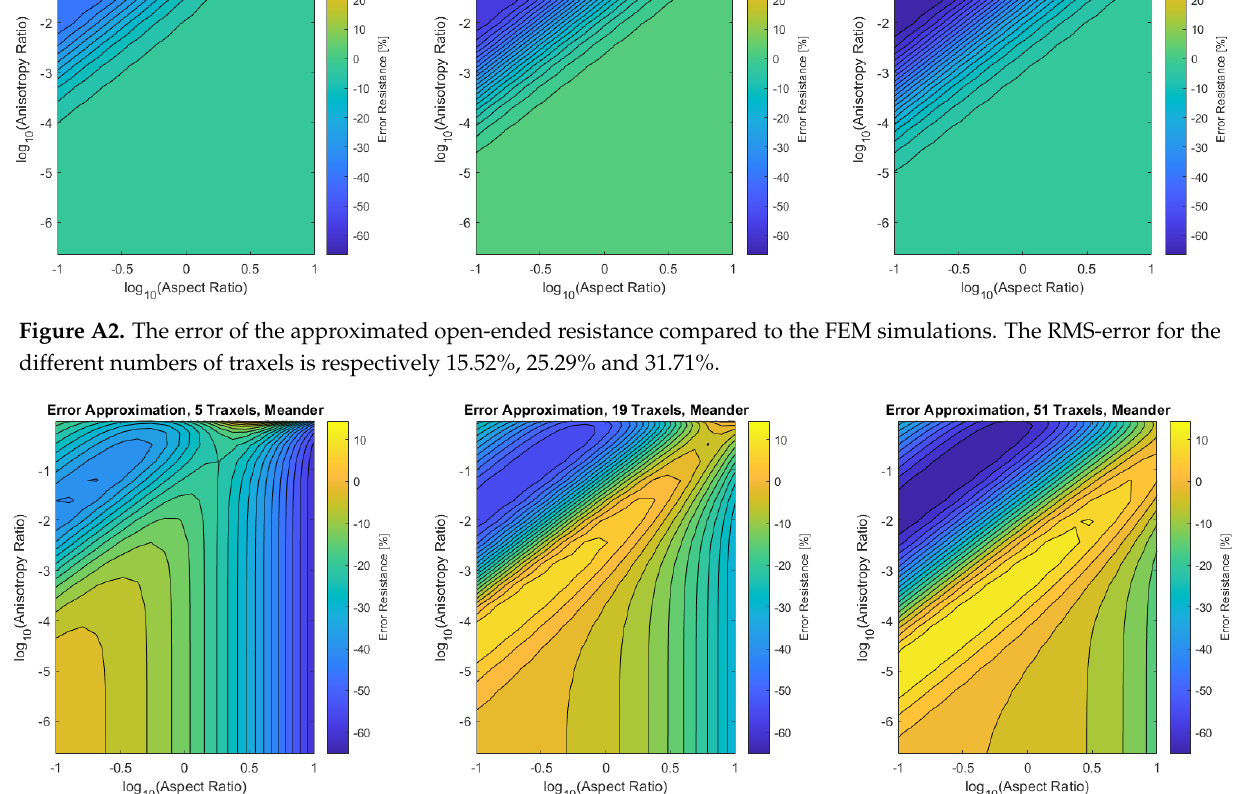
Figure A3. The error of the approximated meandering resistance compared to the FEM simulations. The RMS-error for the different numbers of traxels is respectively 28.39%, 25.25% and